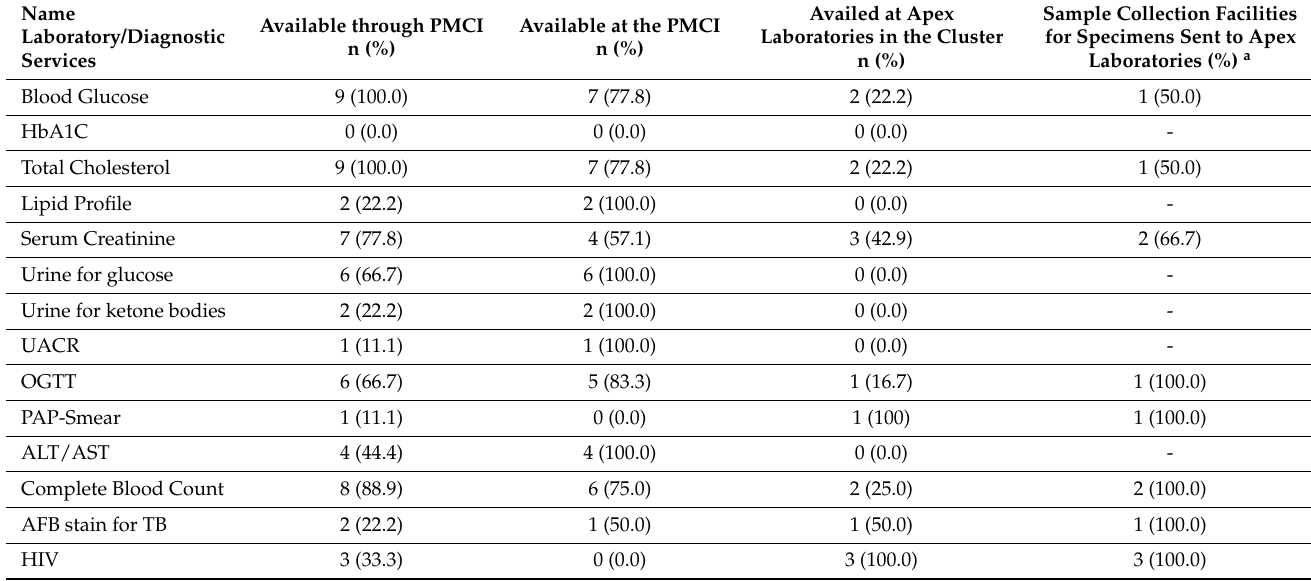
Table 2. Availability of laboratory/diagnostic services in the nine selected PMCIs supported by the PSSP in Sri Lanka in